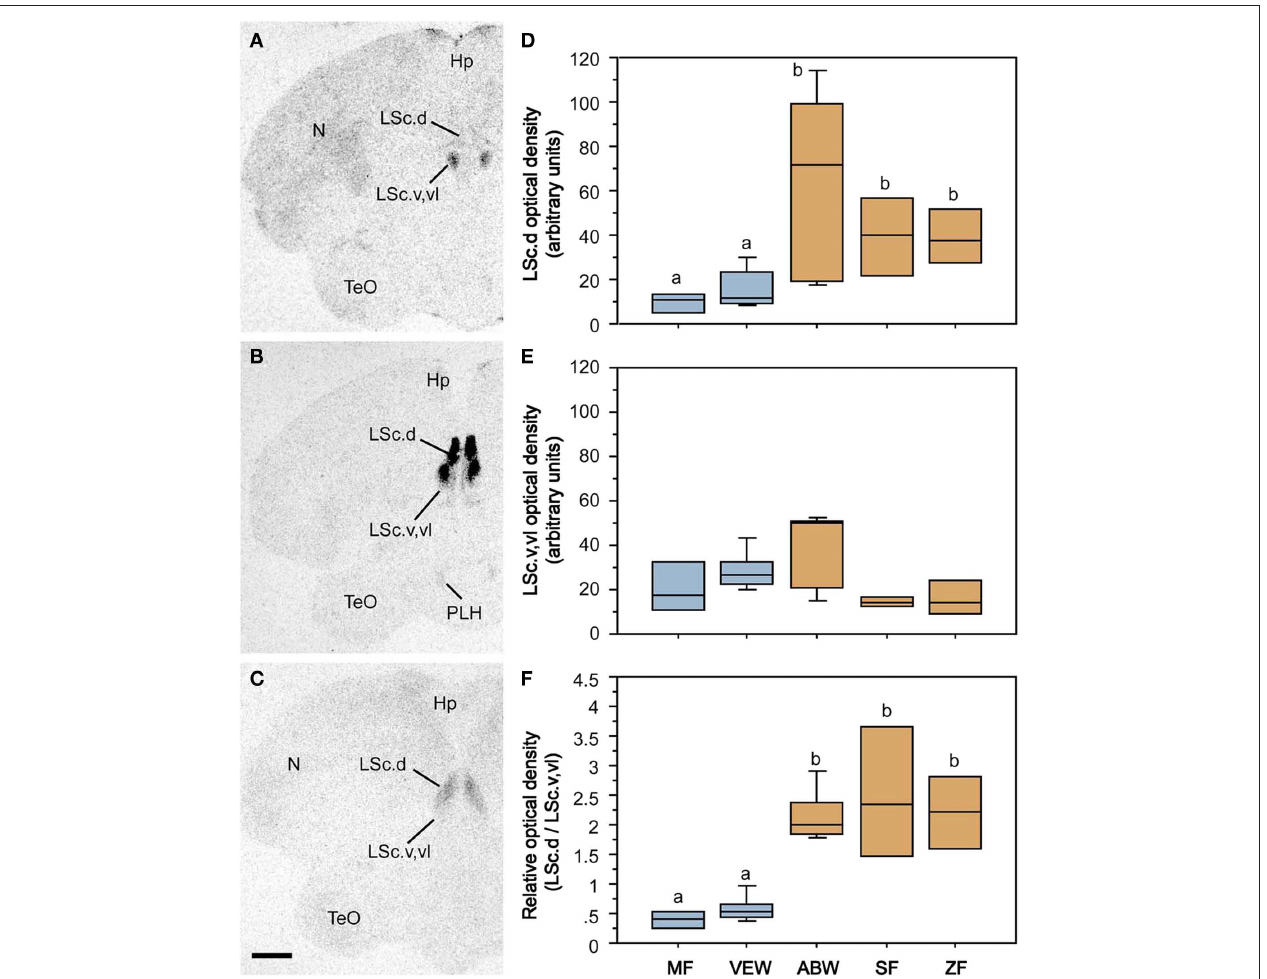
are observed and sexes were pooled. Total n = 23. Different letters above the boxes denote significant species differences (Mann–Whitney P < 0.05) following significant Kruskal–Wallis. (e) Binding densities tend to reverse in the subpallial LSc ( P = 0.06), suggesting that species differences in sociality are most closely associated with the relative densities of binding sites along a dorso-ventral gradient, as confirmed in the bottom (F) using a dorsal:ventral ratio. Abbreviations: Hp, hippocampus; LSc.d, dorsal zone of the LSc; LSc.v,vl, ventral, and ventrolateral zones of the LSc; N, nidopallium; PLH, posterolateral hypothalamus; TeO, optic tectum. Modified from Goodson et al.